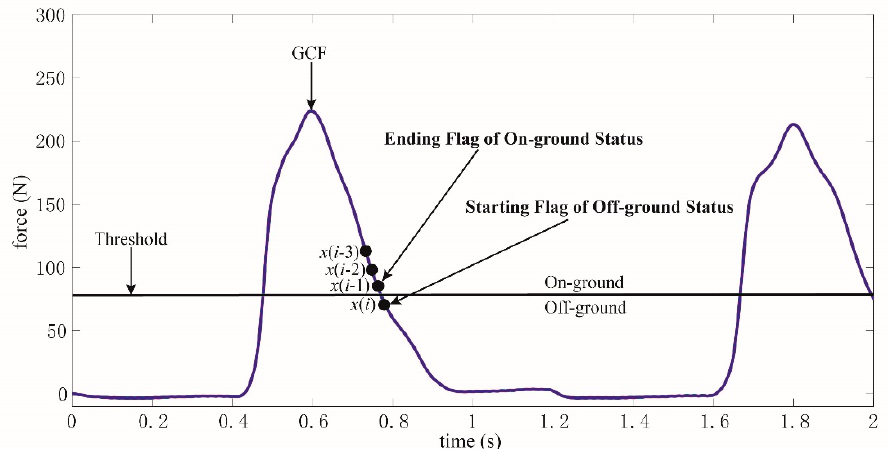
Figure 5. A curve consisting of four GCF points is used to identify the starting flag of off-ground status or the ending flag of on-ground status.